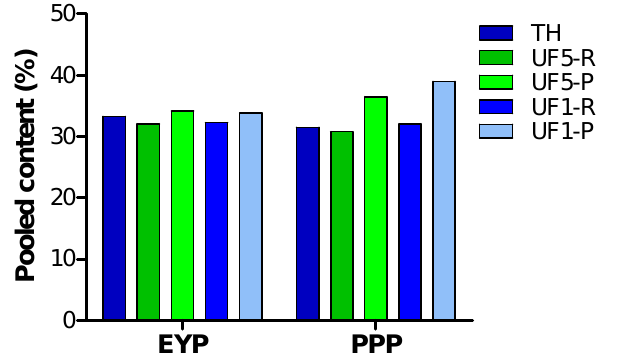
Figure 4. Pooled content (% of total amino acids, protein basis) in His, Lys, Met, Leu, Phe, and Arg of egg yolk proteins (EYP), phosphoproteins (PPP), their hydrolysates and